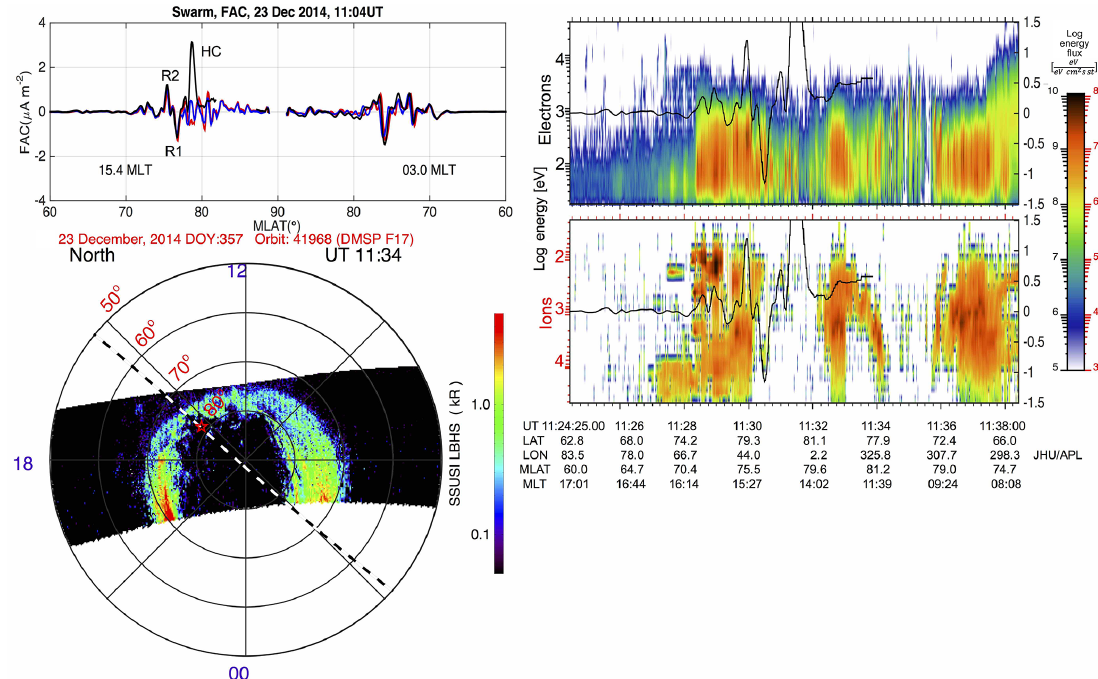
Figure 8. Same format as Fig. 5 but for the Northern Hemisphere and 23 December 2014.